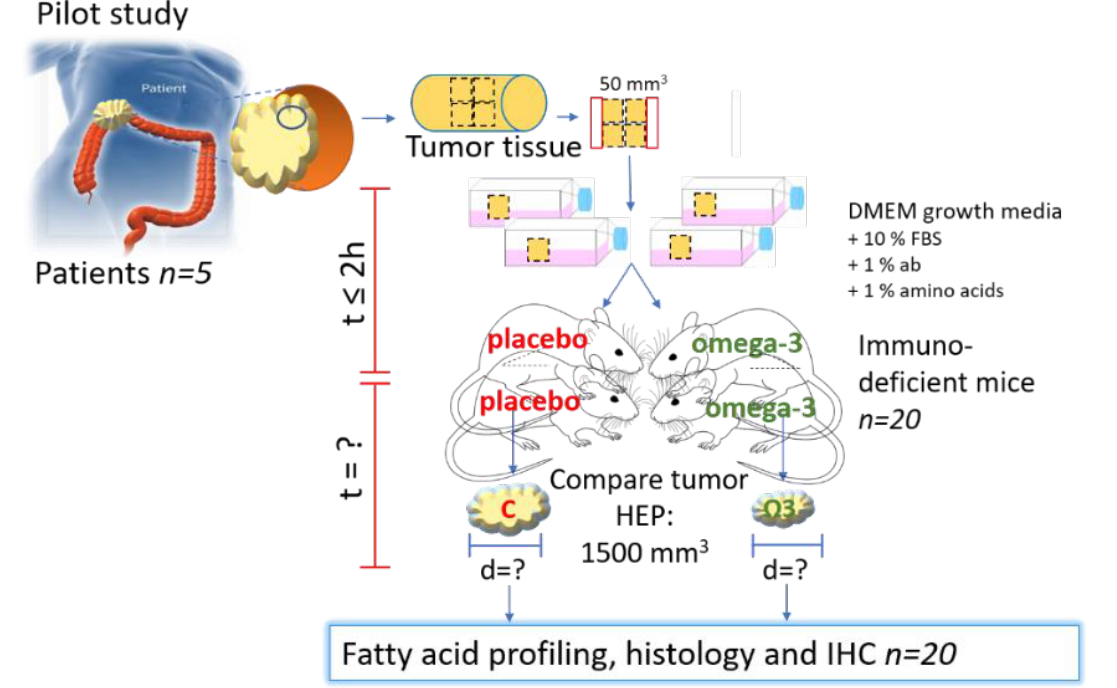
Figure 4. Experimental design of PDX of CRC in mice. C = control/placebo, ω -3 = omega-3, HEP = humane endpoint. Part of the figure is modified from [14] with approval.